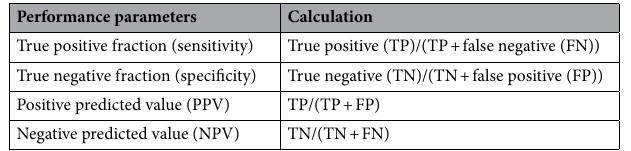
Table 4. Evaluation of the LAMP